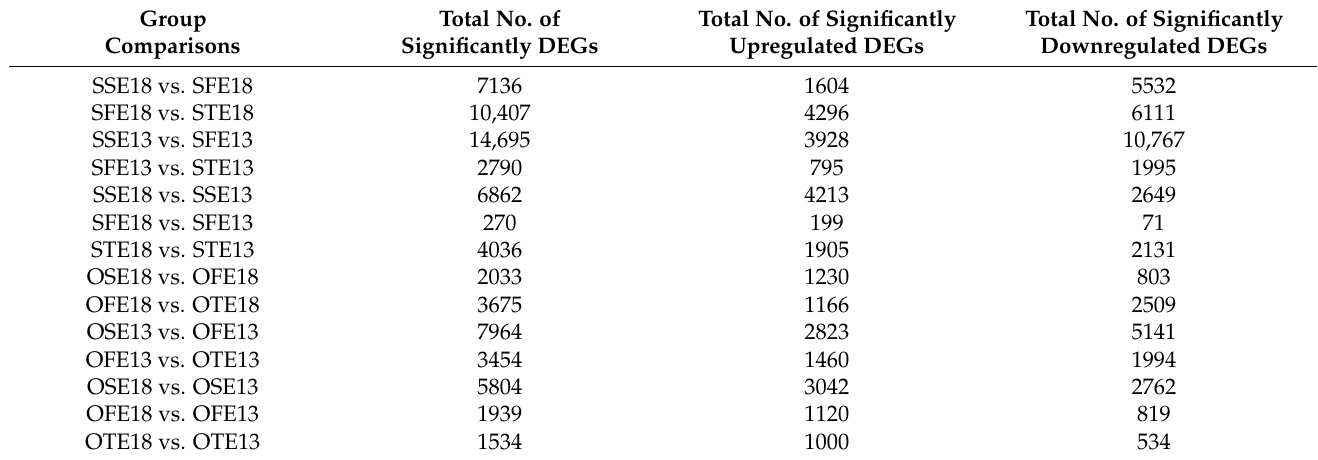
Table 2. Differentially expressed genes (DEGs) in the different treatment